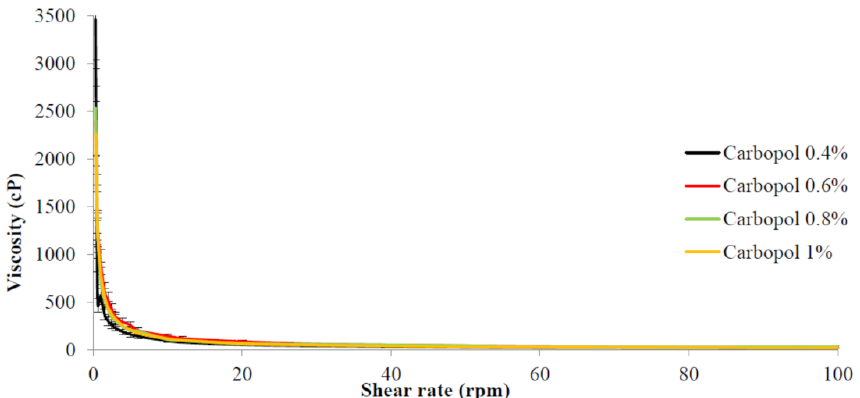
Figure 4. Rheological behavior of Benzoyl peroxide nanoemulgel prepared using different Car- bopol